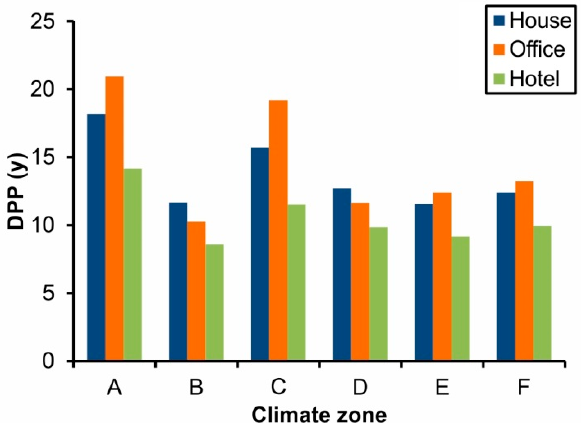
Figure 8. Discount Payback Period (DPP, [54]) for the subsidized GCHP system installation in poorly-insulated building refurbishing cases in the different climate zones (Table 2).